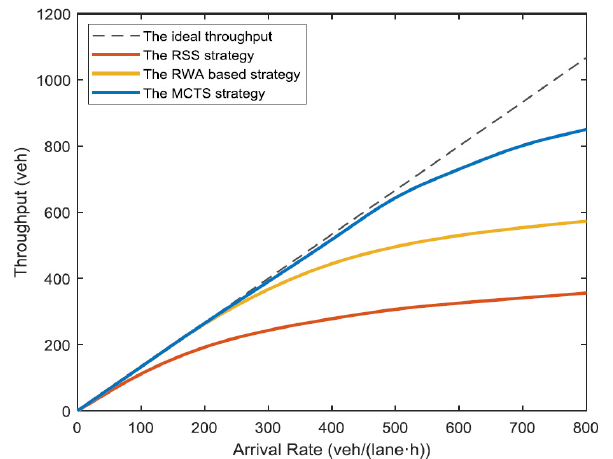
Figure 5. Comparison between RWA, CDS, and RSS in terms of average delay/arrival rate [32].